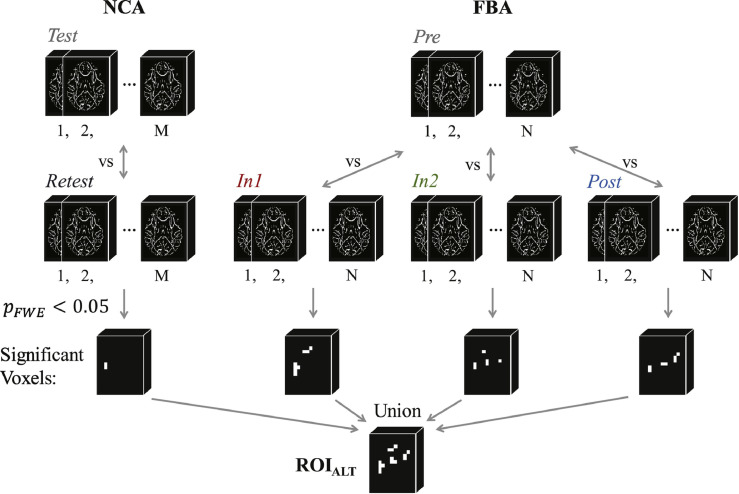
Illustration of the process by which the altered white matter mask, ROIALT, was generated. Pair-wise (by session) permutation t-tests (50,000 permutations) were conducted for all follow-up sessions (NCA: Retest; FBA: In1, In2, Post) with baseline (NCA: Test; FBA: Pre) to identify voxels exhibiting a statistically-significant change (pFWE < 0.05) at that follow-up session. The resulting sets of voxels for each follow-up session were merged to produce the altered white matter mask. See text (Group-level altered WM mask) for details.